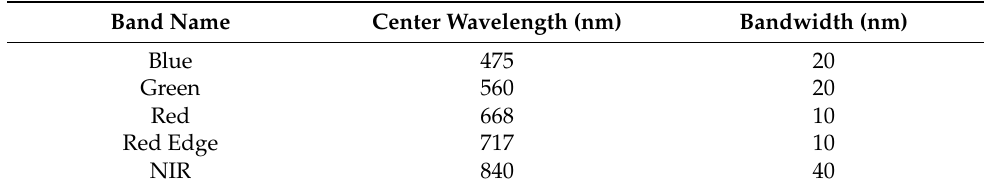
Table 3. Spectral band information for the Micasense